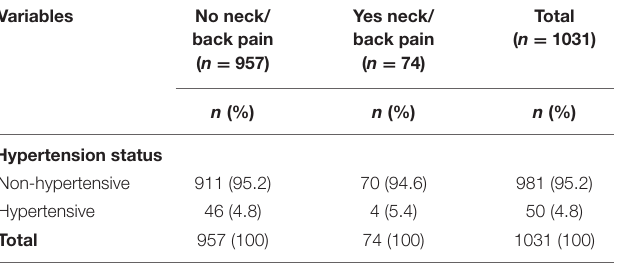
TABLE 5 | Comparison between hypertension status and Neck/Back status in the Al-Kharj population sample ( n = 1,031).